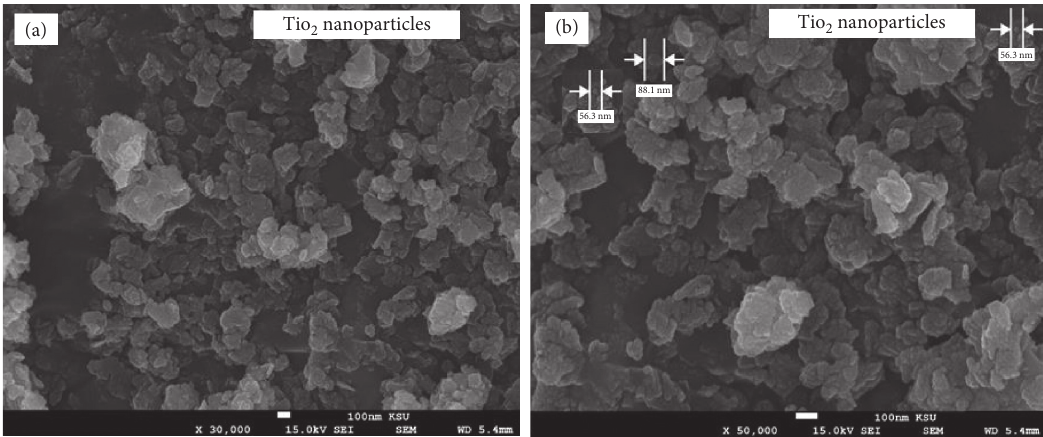
Figure 3: SEM images of TiO 2 nanoparticles at (a) 30,000x and (b) 50,000x magnifications.